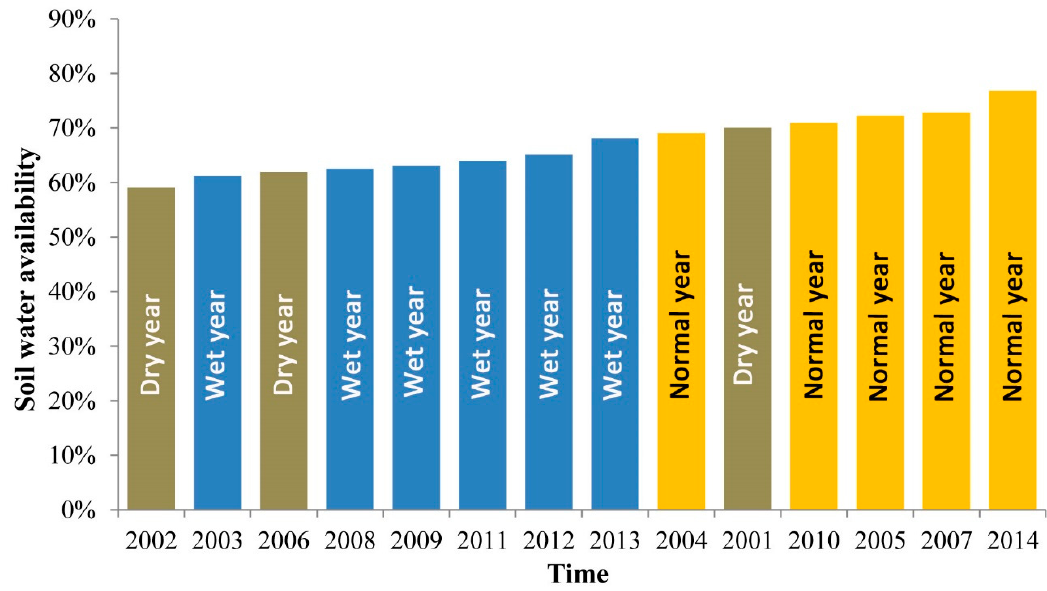
Figure 6. SWA ranking in different hydrological level years.